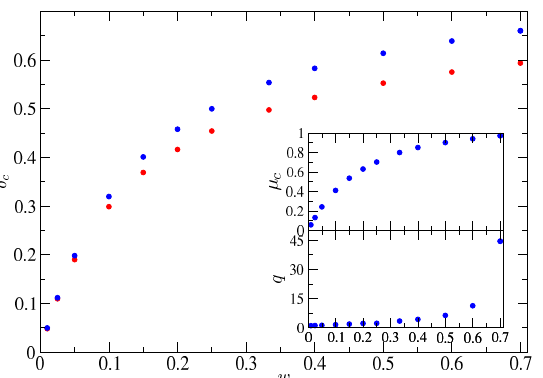
Figure 15. Thresholds δ c in terms of w for two profiles. Red dots correspond to the Gaussian profile with K ( r ) and blue dots to ζ ( ˜ r ) instead. The ( top-subplot ) is the critical amplitude µ c of the profile in ζ ( ˜ r ) . The ( bottom-subplot ) is the value q of the critical profile ζ ( ˜ r ) for each w